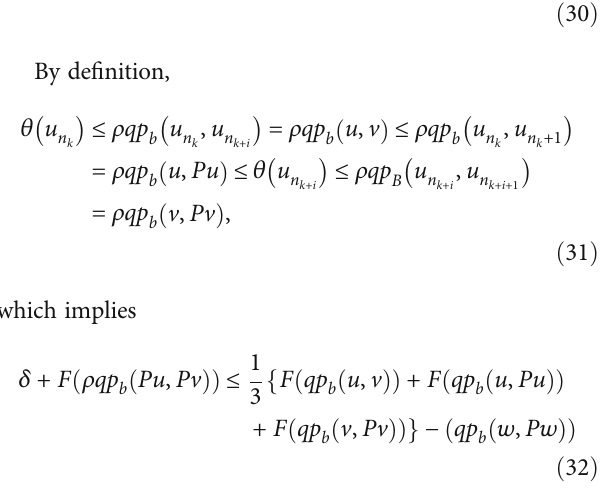
ffiffiffi p where u ∈ ð 0, 10 Þ , v ∈ ð 0, 10 Þ u